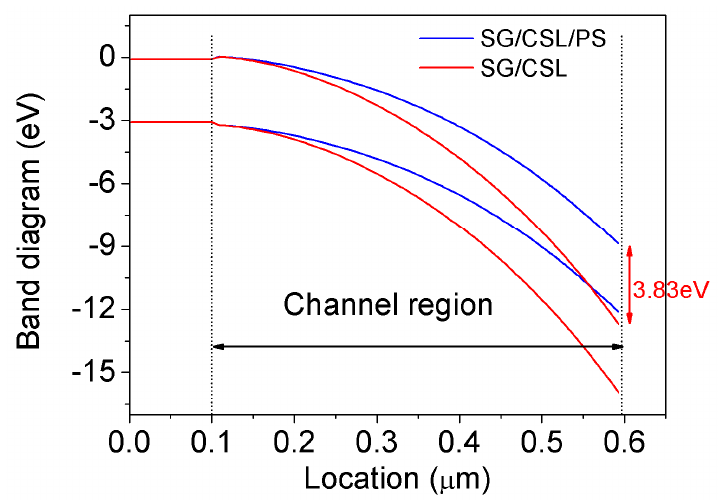
Figure 9. Id-Vds curves in the saturation region of SG/CSL and SG/CSL/PS.